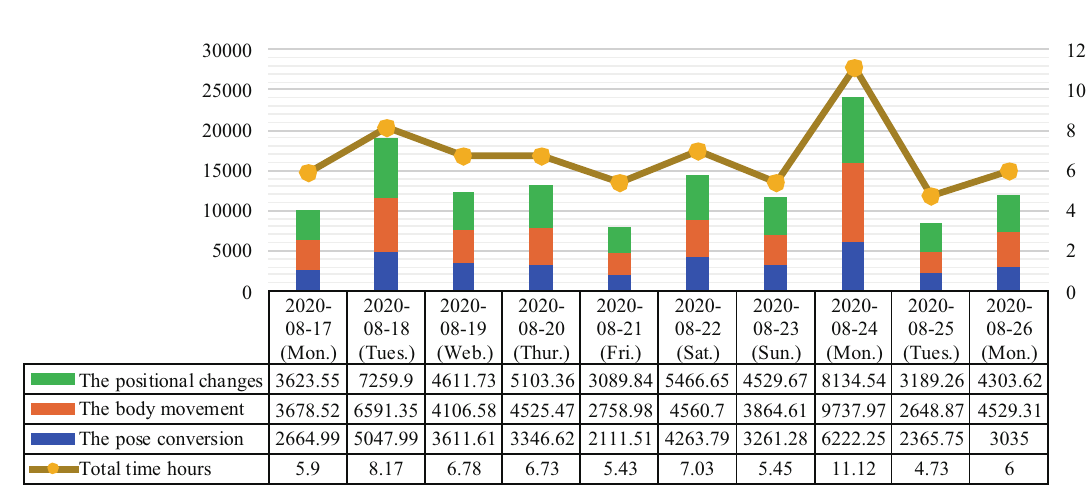
Figure 9. Cumulative results of all parameters and total time hours on each day.